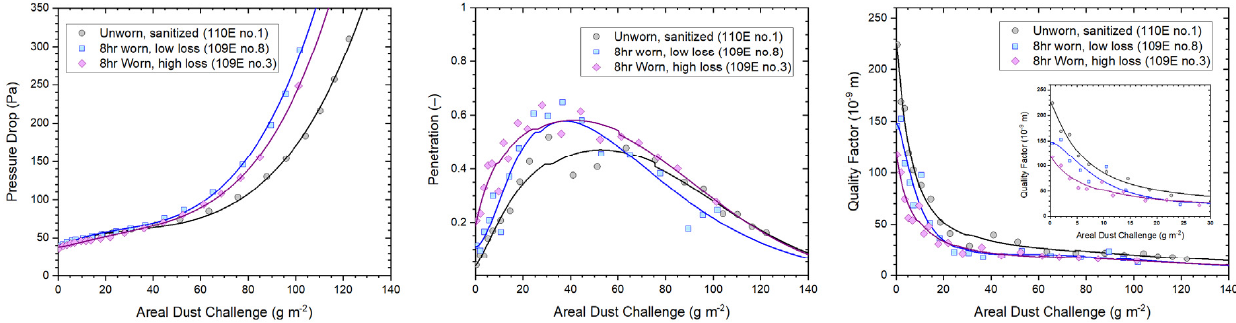
Figure 8. Dust loading performances of sanitized mask media in unworn and worn state. Low and high loss refer to the observed level of deterioration that the mask media incurred during wear. Mathematical fit functions used to illustrate dust loading dependencies were described in [25].